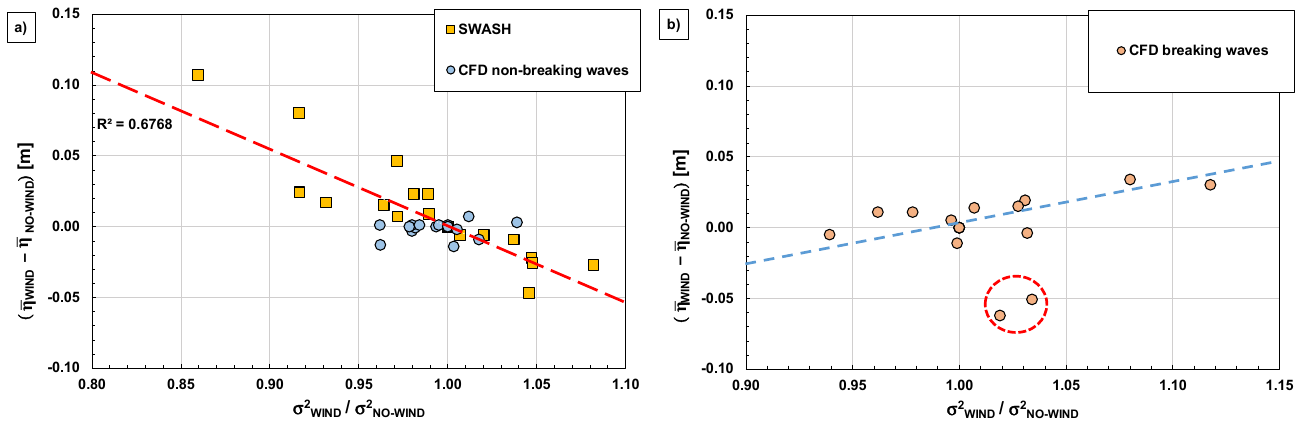
Figure 5. Variation of η as a function of σ 2 WIND / σ 2 NO-WIND ratio. Panel ( a ): results for non-breaking waves; panel ( b ): results for breaking waves.